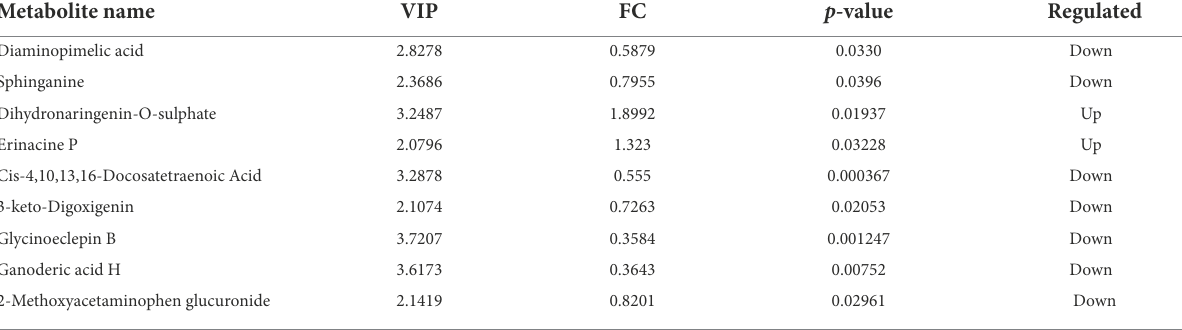
TABLE 4 Different metabolites in the meat rabbit serum after heat